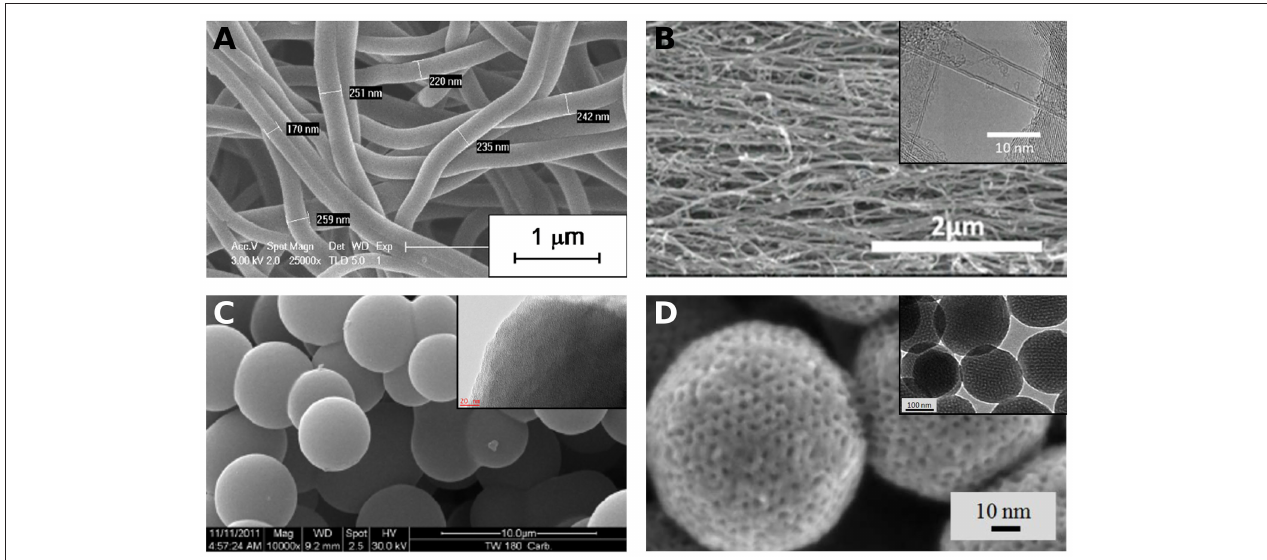
FIGURE 6 | (A) Electrospun CNFs from Kraft lignin (Adapted from Vivo-Vilches et al., 2019). SEM (and TEM in the insets) images of: (B) commercial CNTs-Poly(dicyclopentadiene) composite yarn (Adapted from Xin et al., 2020); (C) solid CNSs derived from tannin (Adapted with permission of Elsevier, from